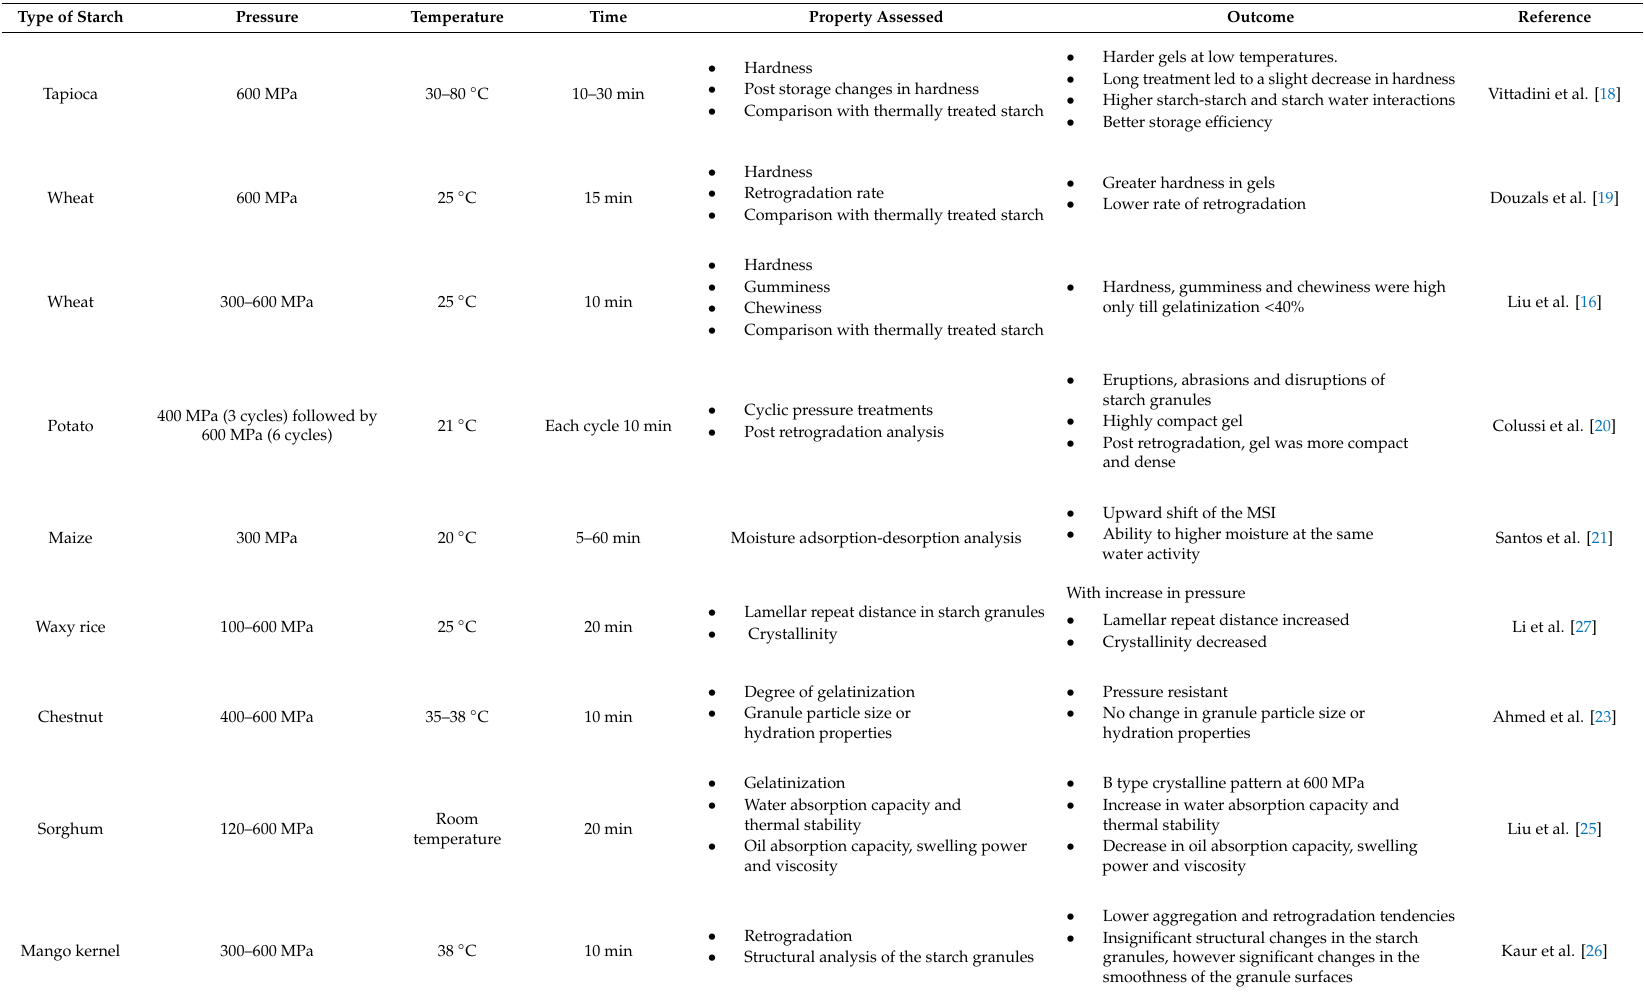
Table 1. Important highlights of the studies on di ff erent HPP treated